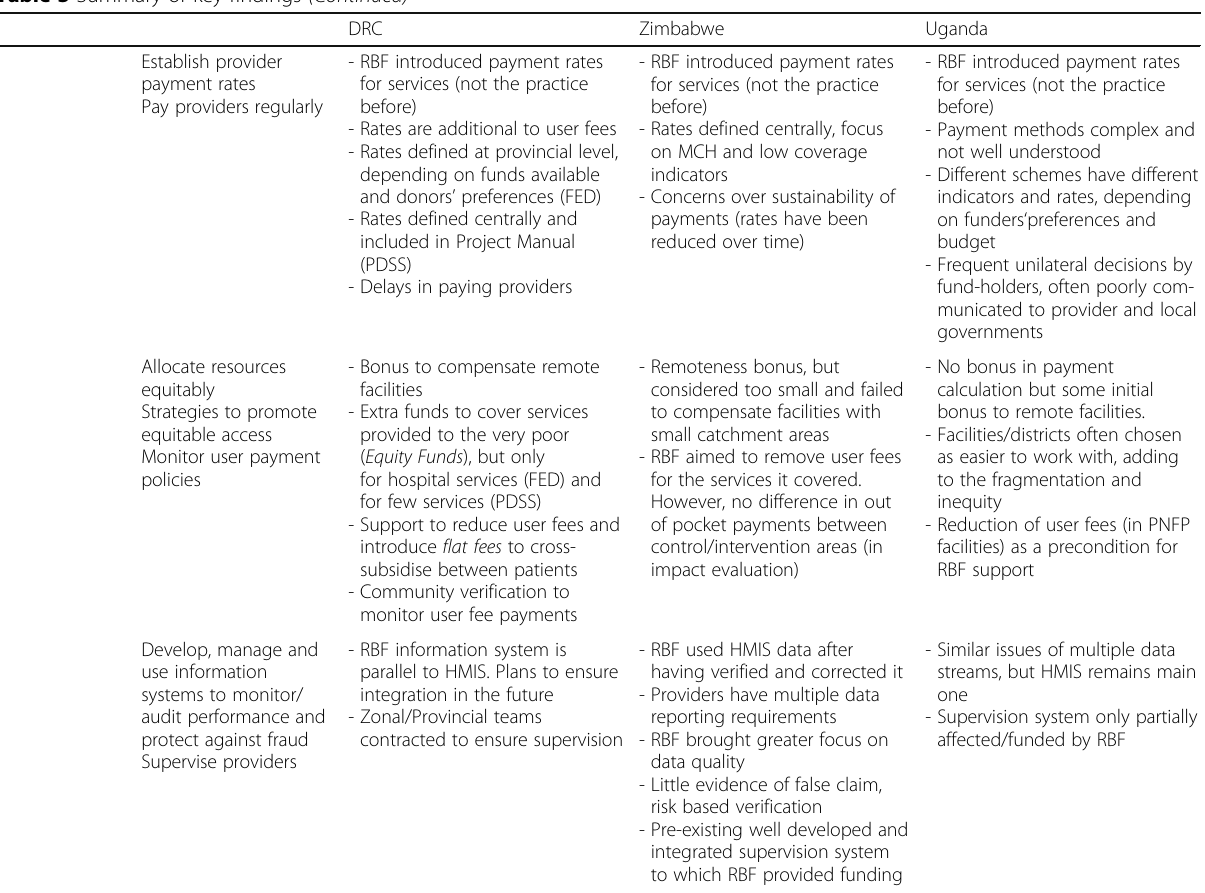
Table 3 Summary of key findings